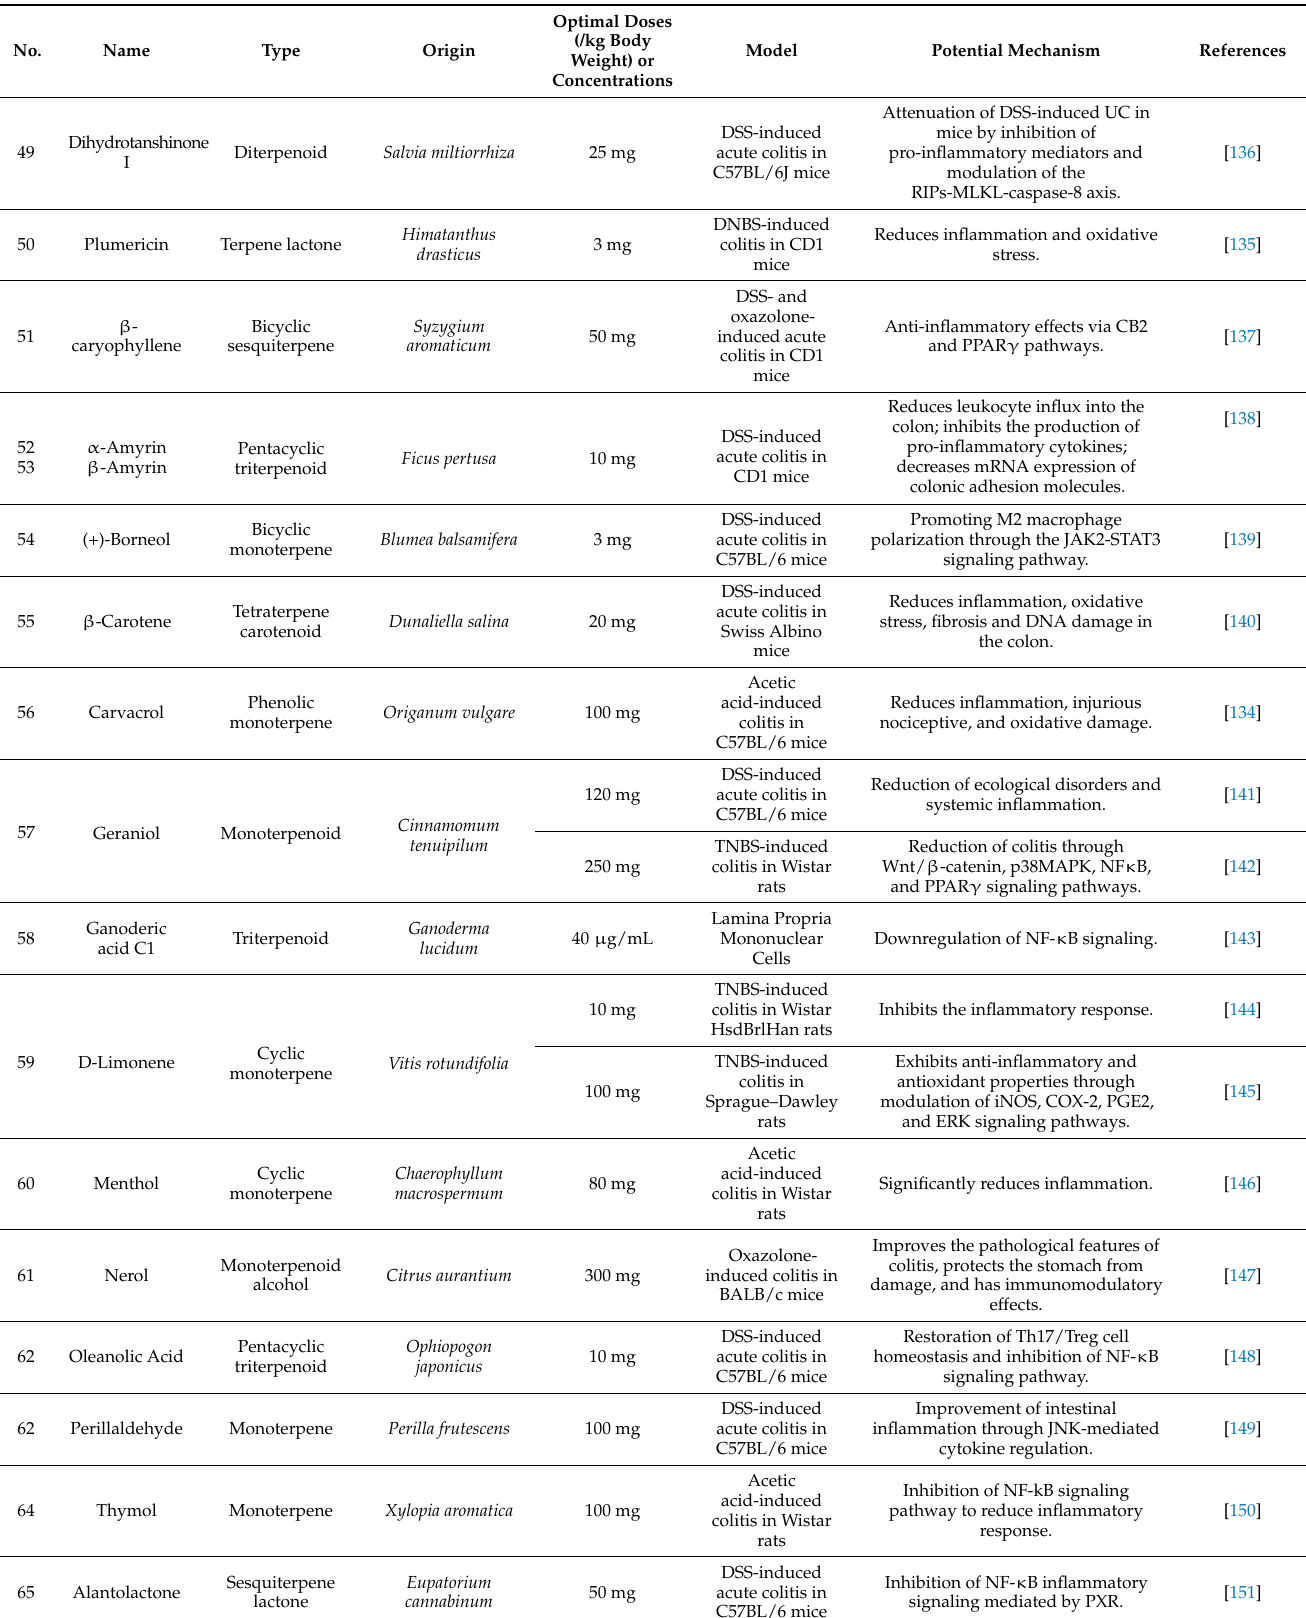
Table 2. In vivo therapeutic effects of terpenoids on experimental